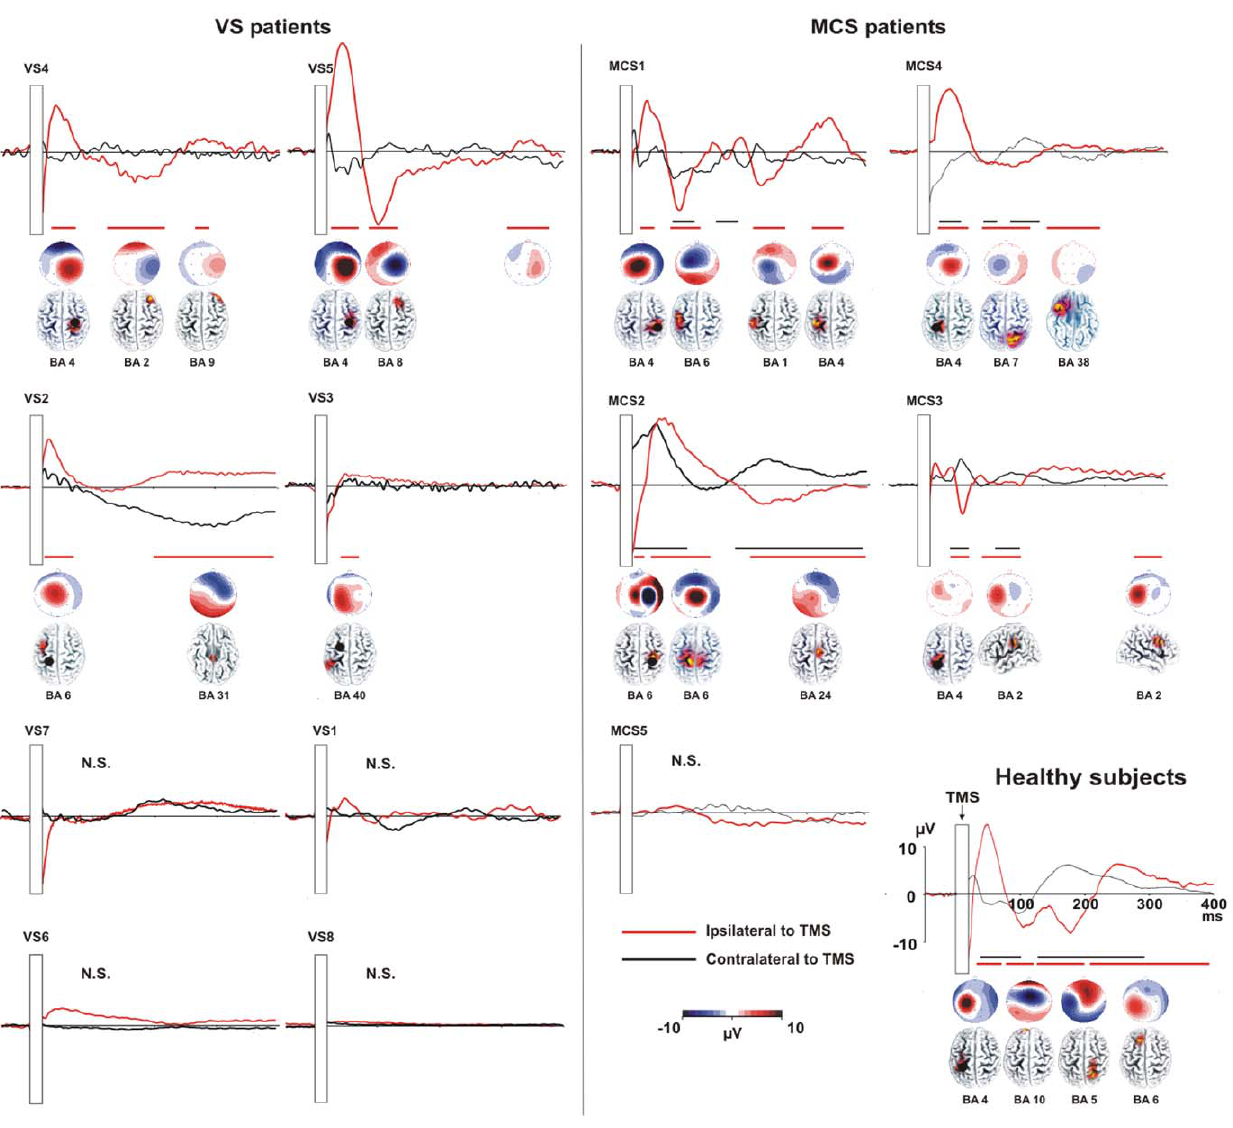
Figure 1. TEPs recorded in VS patients, MCS patients and healthy controls (grand average of five individuals). The figure presents the TEPs recorded from C3 and C4 following stimulation of the left or right M1 in VS (left insert) and MCS patients (right insert). The right lower part of the figure indicates the grand average TEPs obtained in five healthy controls stimulated above the left primary motor cortex (M1; C3). For all patients and the control group, the presented TEPs were recorded from the closest electrode to the hot-spot (ipsilateral to TMS – red line) and from the corresponding electrode on the contralateral hemisphere (black line). The hot-spot is indicated with a black dot. The responses obtained during the sham condition were point-by-point subtracted from those obtained during the real TMS. The significant time-windows (i.e., EEG signal exceeding three times the standard deviation of the pre-stimulus activity for at least 20 ms) are separately indicated for the ipsilateral electrode with a horizontal red line and for the electrodes contralateral to the TMS hot-spot with a black